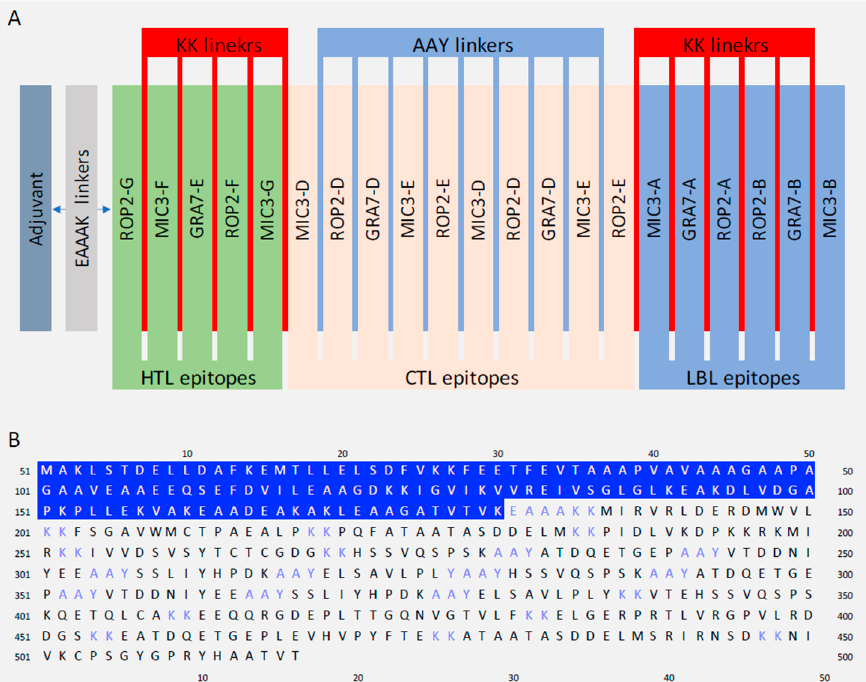
Figure 1. The final T. gondii multi-epitopes vaccine design. ( A ) A graphical presentation of the T. gondii multi-epitope vaccine design. The candidate vaccine construct containing (left to right) an adjuvant, HTL, CTL and LBL. ( B ) The primary structure of the designed vaccine in one letter format of amino acid, adjuvant (blue highlight), linkers (blue) and epitopes (black). Table 4. Antigenic, allergenic, and physiochemical characteristics of the